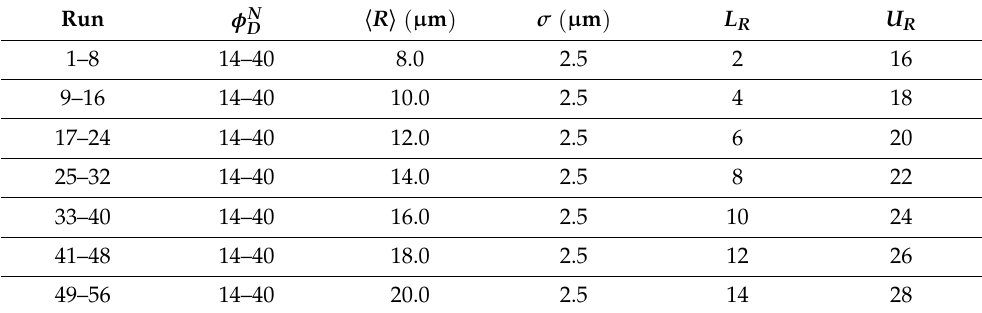
Table 3. Initial volume fraction of PAMS-rich domains φ N deviation of the initial Gaussian distribution of domains σ , and lower and upper cut-offs of the size